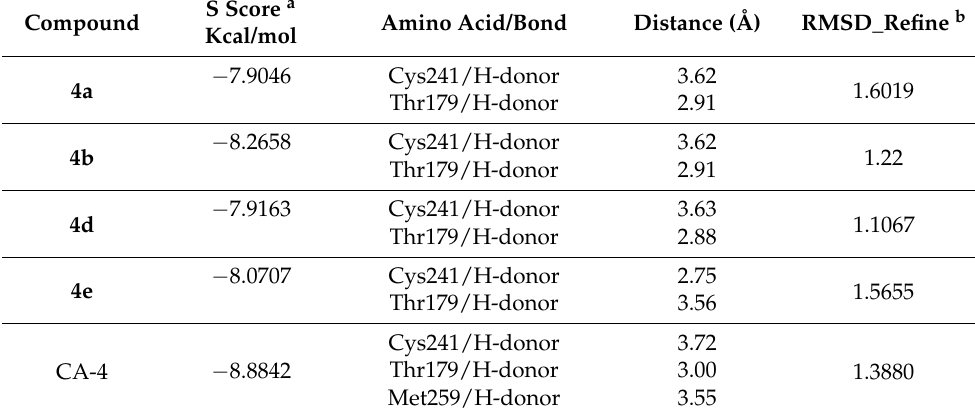
Figure 10. Two-dimensional diagram ( A ) and 3D representation ( B ) of compound 4b (cyan) with the CA-4 binding site of tubulin (PDB code: 5LYJ). Table 5. Docking energy scores (S) in kcal/mol, interacting amino acid, distance in Å of the tested compound ( 4a, 4b, 4d, 4e and CA-4 ), and RMSD_Refine assessed upon docking compounds 4a–e and CA-4 at the colchicine binding site of tubulin (PDB code: 5LYJ).